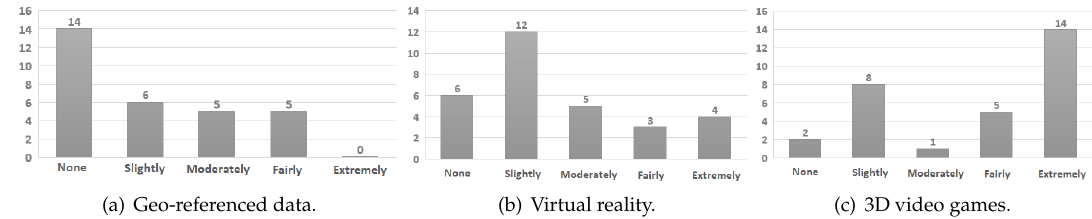
Figure 10. Distributions of participants’ experience with geo-referenced data, virtual reality, and 3D video games.